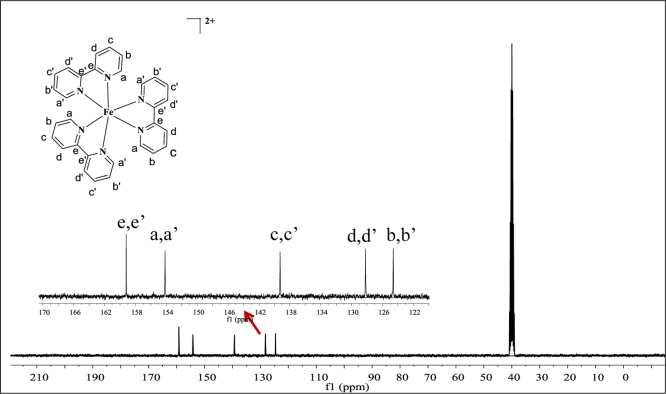
13C NMR spectrum (300 MHz) of complex 1 in dimethylsulfoxide-d6.